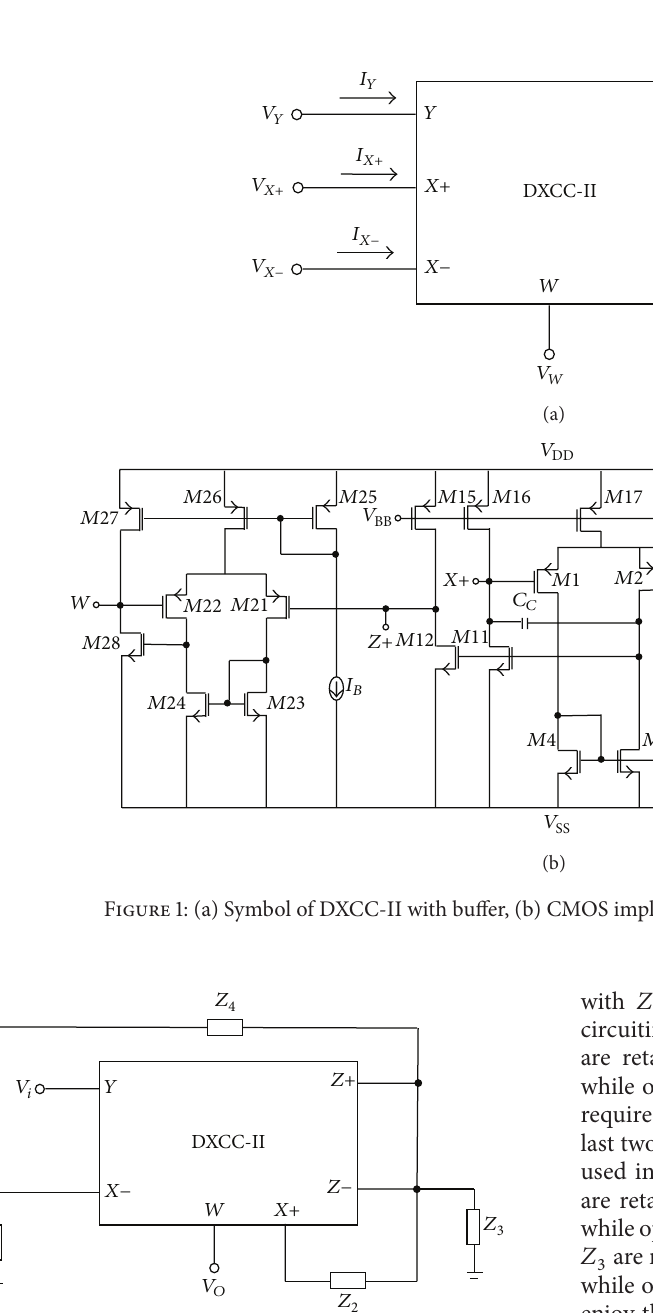
Figure 2: Topology extension by interchanging 𝑋 ports of a recent work